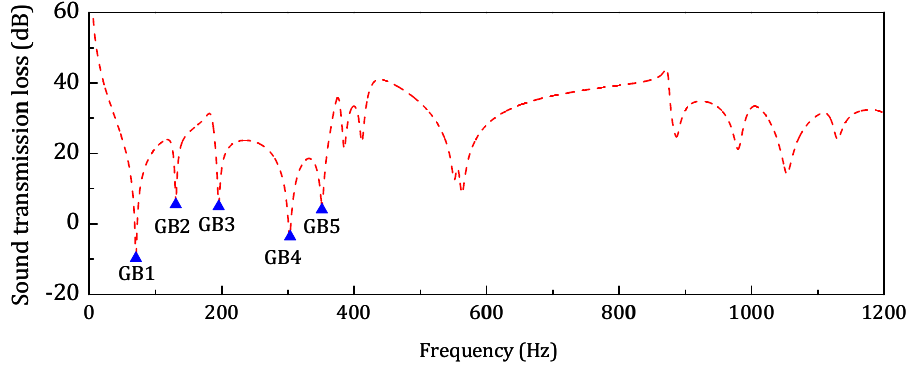
Figure 17. STL spectrum of the baseline model (GB, Global bending mode).